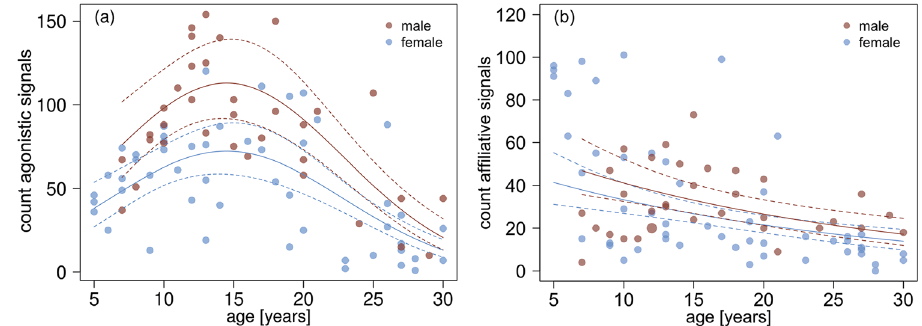
Fig. 1 Variation in signal usage in relation to age. a Total number of agonistic signals produced in relation to age (model 1, N = 5485 signals). b Total number of af fi liative produced in relation to age (model 2, N = 2700 signals). Females ( N = 50) are represented by blue, males ( N = 34) by brown points. Point size represents the frequency of a signal at a given age (range 1 to 2). The solid lines depict the fi tted model, and the dashed lines indicate their lower (2.5 %) and upper (97.5 %) con fi dence limits. The model shown in b is for an individual with an average rank (determined separately for females